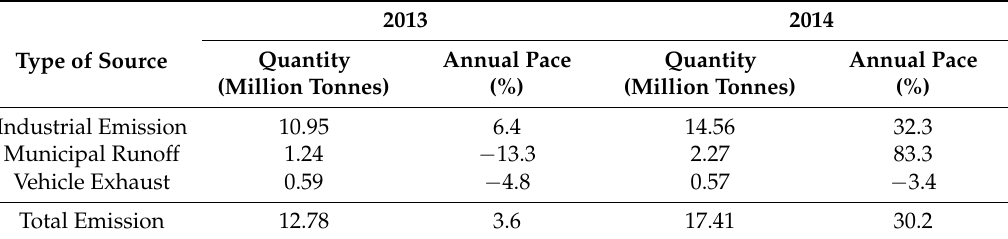
Table 2. Emission structure of smoke and dust 1